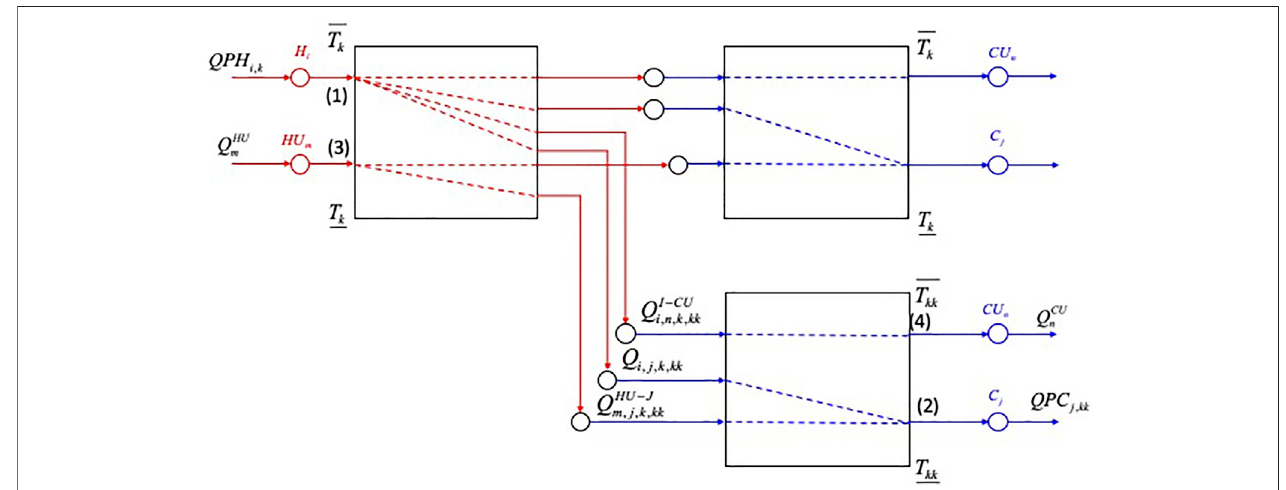
FIGURE 1 | Scheme of the TransHEN model. Points (1), (2), (3), and (4) indicate the locations of the energy balances in the transportation model when heat is transported from interval k to interval kk .